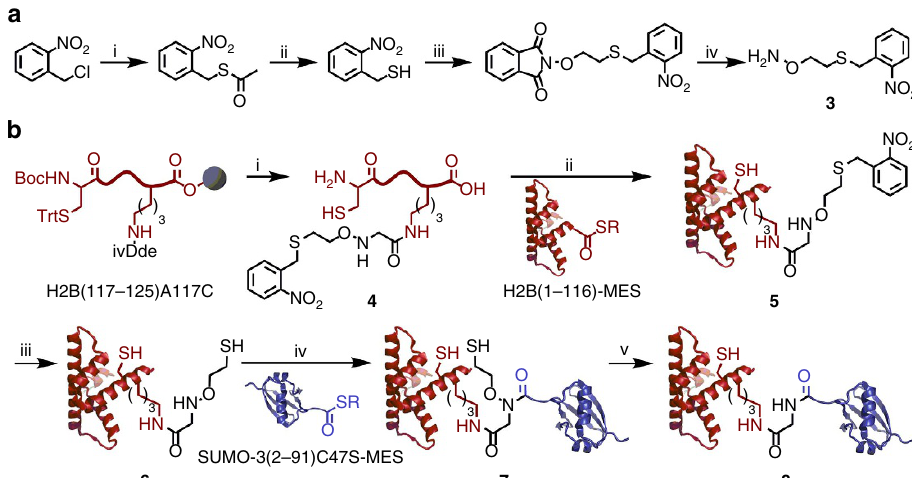
Figure 5 | Semisynthesis of full-length sumoylated histone H2B(A117C). ( a ) Synthesis of photoprotected auxiliary 3 . (i) CH 3 C(O)SH, K 2 CO 3 , THF, 8h, 25 (cid:2) C. (ii) HCl, CH 3 OH, 6h, 60 (cid:2) C, 75% (2 steps). (iii) N -(2-bromoethoxy)phthalimide, Et 3 N, DMSO, 4h, 25 (cid:2) C, 74%. (iv) H 2 NNH 2 , CHCl 3 , 1h, 25 (cid:2) C, 98%. ( b ) (i) Site-specific coupling of 3 to H2B(117–125)A117C Lys120 followed by acidolytic release of the unprotected peptide, 4 , from the solid-phase. (ii) Expressed protein ligation of 4 with H2B(1–116)- a -thioester to generate full-length H2B(A117C) with protected auxiliary at Lys120, 5 . (iii) photolytic removal of the auxiliary protecting group to give H2B(A117C) with unprotected auxiliary at Lys120, 6 . (iv) Expressed protein ligation of 6 with SUMO-3 (2–91)C47S- a -thioester to generate sumoylated H2B(A117C) 7 , with retention of the ligation auxiliary. (v) Selective removal of the ligation auxiliary with 150mM MPAA under non-denaturing conditions to yield sumoylated H2B(A117C) 8 . ivDde ¼ 1-(4,4-Dimethyl-2,6-dioxocyclohexylidene)-3-methylbutyl group. PDB codes, 1KX5 (H2B) and 1U4A